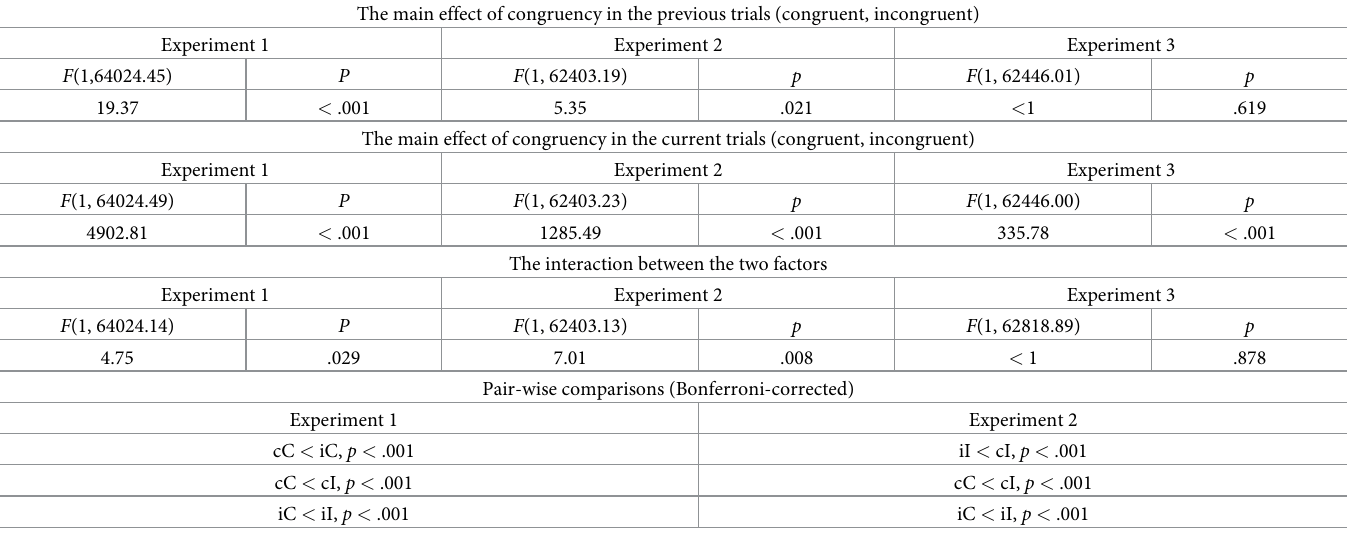
Table 2. Test statistics for the RTs on the single-trial level of each condition of each participant in Experiments 1, 2, & 3. The main effect of congruency in the previous trials (congruent,